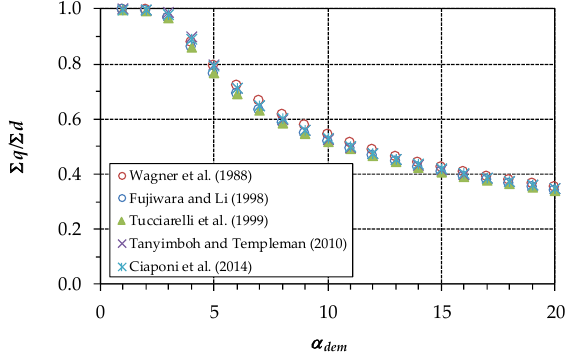
bisector, apart from close to the 0 of the Wagner et al. formulation, in correspondence to which the Figure 5. First case study. Satisfaction rate ∑ q / ∑ d for the various formulations as a function of α dem . Figure 5. First case study. Satisfaction rate ∑ q /∑ d for the various formulations as a function of α dem . other formulations seem to overestimate h .